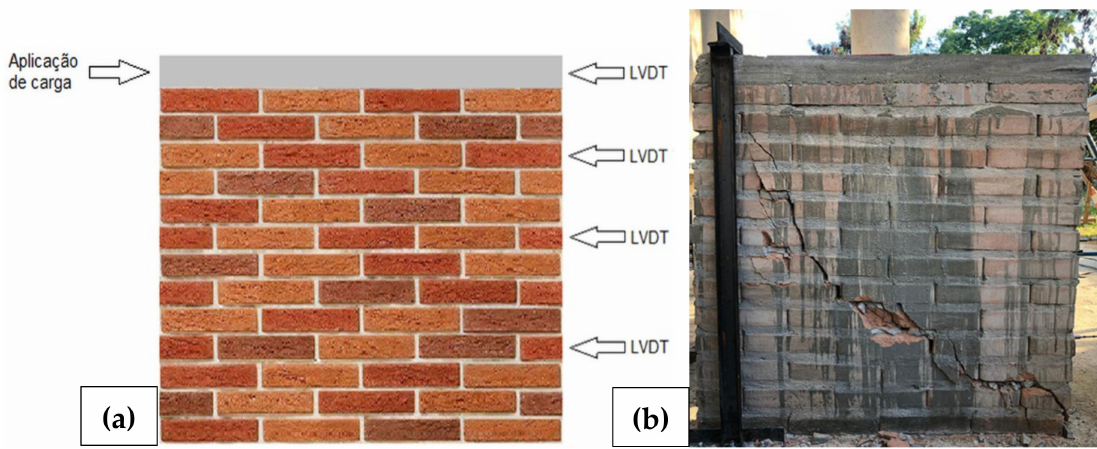
Figure 7. ( a ) Design of horizontal load tests; ( b ) Final stage with the cracked wall